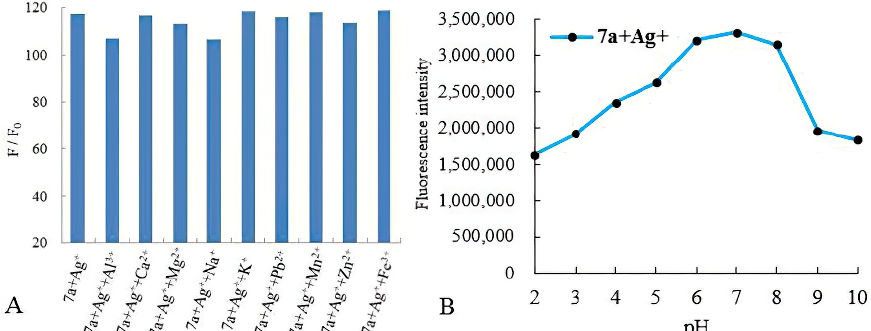
Figure 2. ( A ) Effect of other metal ions (4.5 × 10 − 5 mol/L) on fluorescence intensity of host 7a (9 × 10 − 6 mol/L) for Ag + (4.5 × 10 − 5 mol/L) recognition. ( B ) Fluorescence spectra of the host compound 7a (9 ×